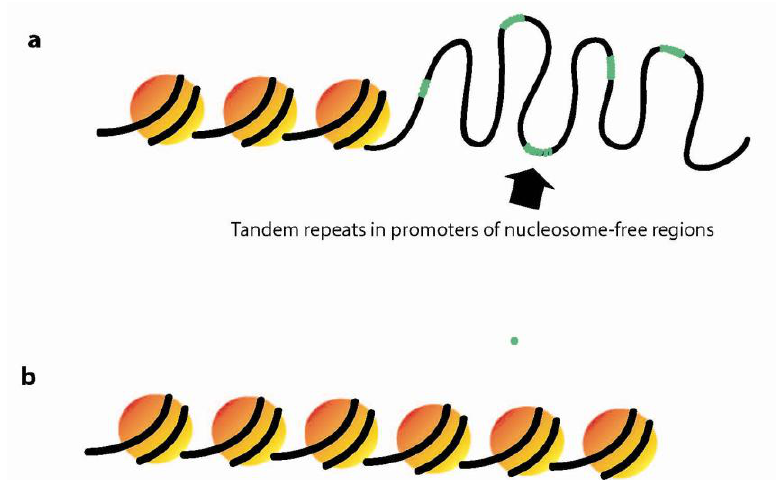
Figure 3. TRs mediate dynamic chromatin structure. ( a ) TR enrichment in promoter regions is nucleosome-inhibiting and allows for an open chromatin structure; ( b ) Nucleosome-dense regions lack TRs in promoter regions of the